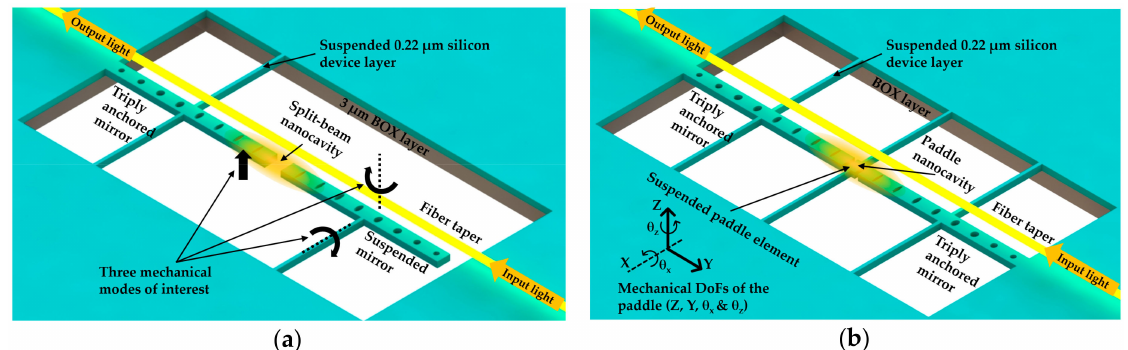
Figure 16. Optomechanical sensors based on split nanobeam cavity: ( a ) nanocavity torque sensor; ( b ) optomechanical paddle